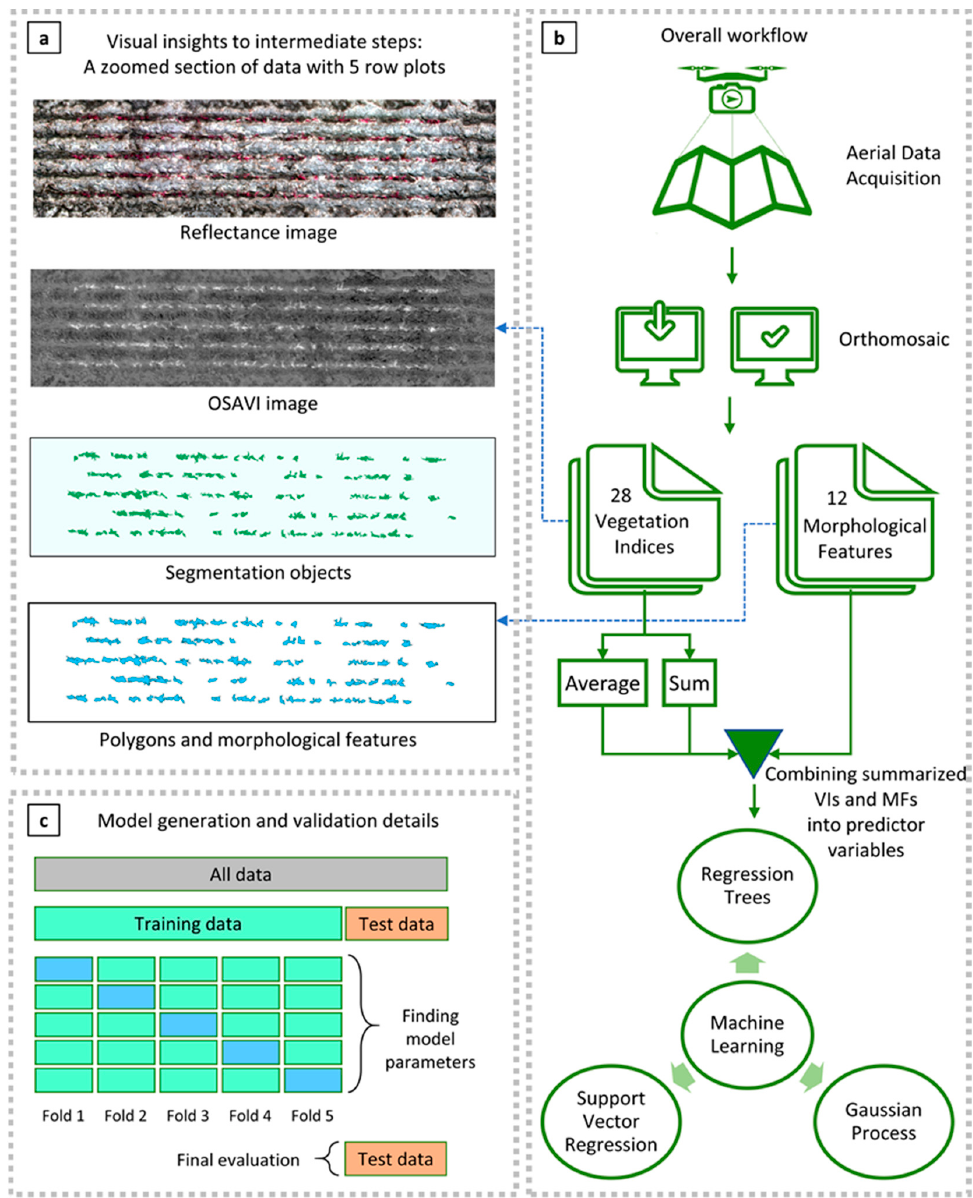
Figure 2. Workflow for image processing and analysis. (a) Visual insights of intermediate steps in the workflow showing reflectance, OSAVI image, segmented objects and extracted polygons and morphological features; (b) overall workflow adopted in this study covering data acquisition, orthomosaicking, vegetation index, morphological features, summarization of the image layers into predictor variables and used machine learning regressors; (c) model generation and validation details covering both cross-validation and dedicated testing.